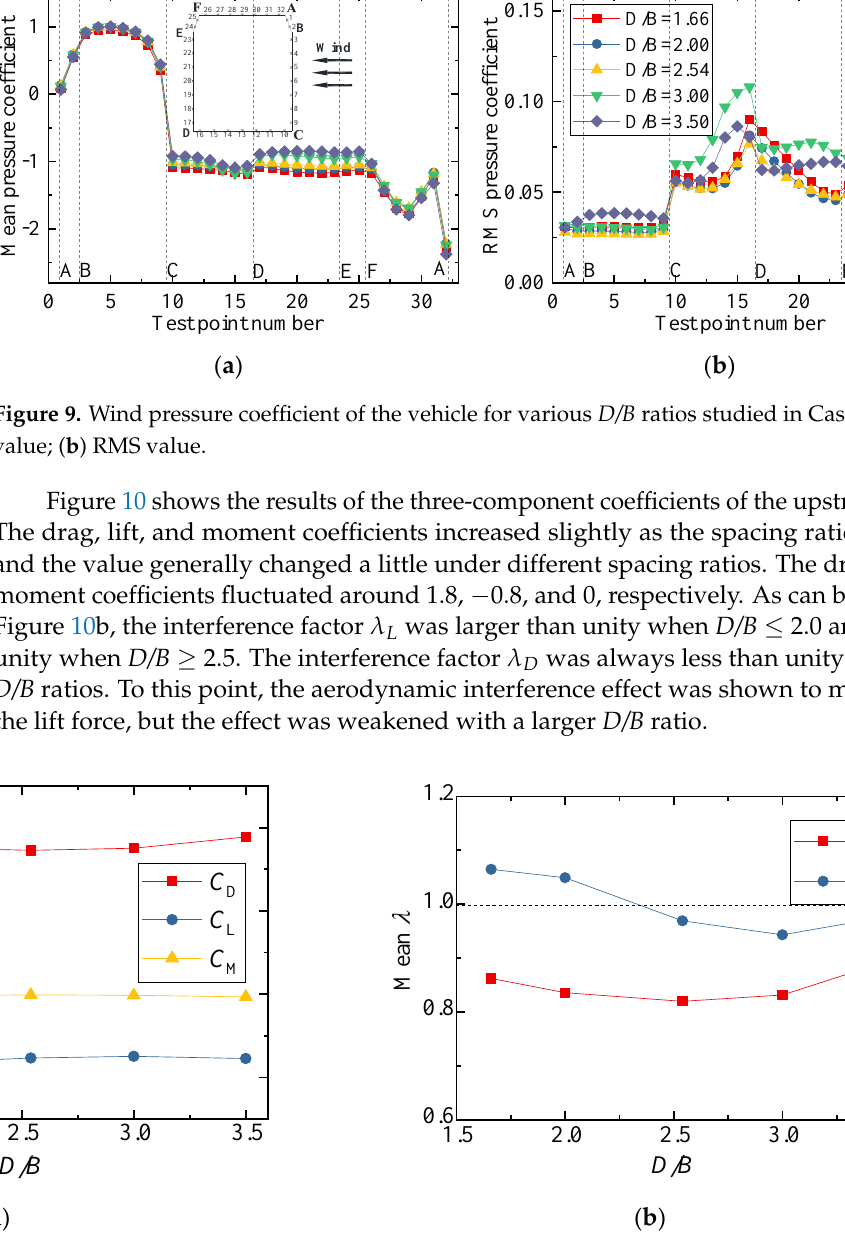
Figure 10. Comparison of the ( a ) aerodynamic coefficients and ( b ) interference factor for the upstream bridge for the various D/B ratios investigated in Case 2.